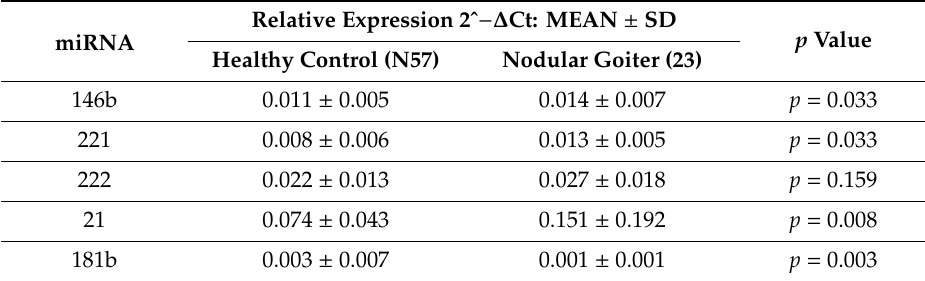
Table A3. miRNA expression comparison between nodular goiter patients and healthy control plasma samples.